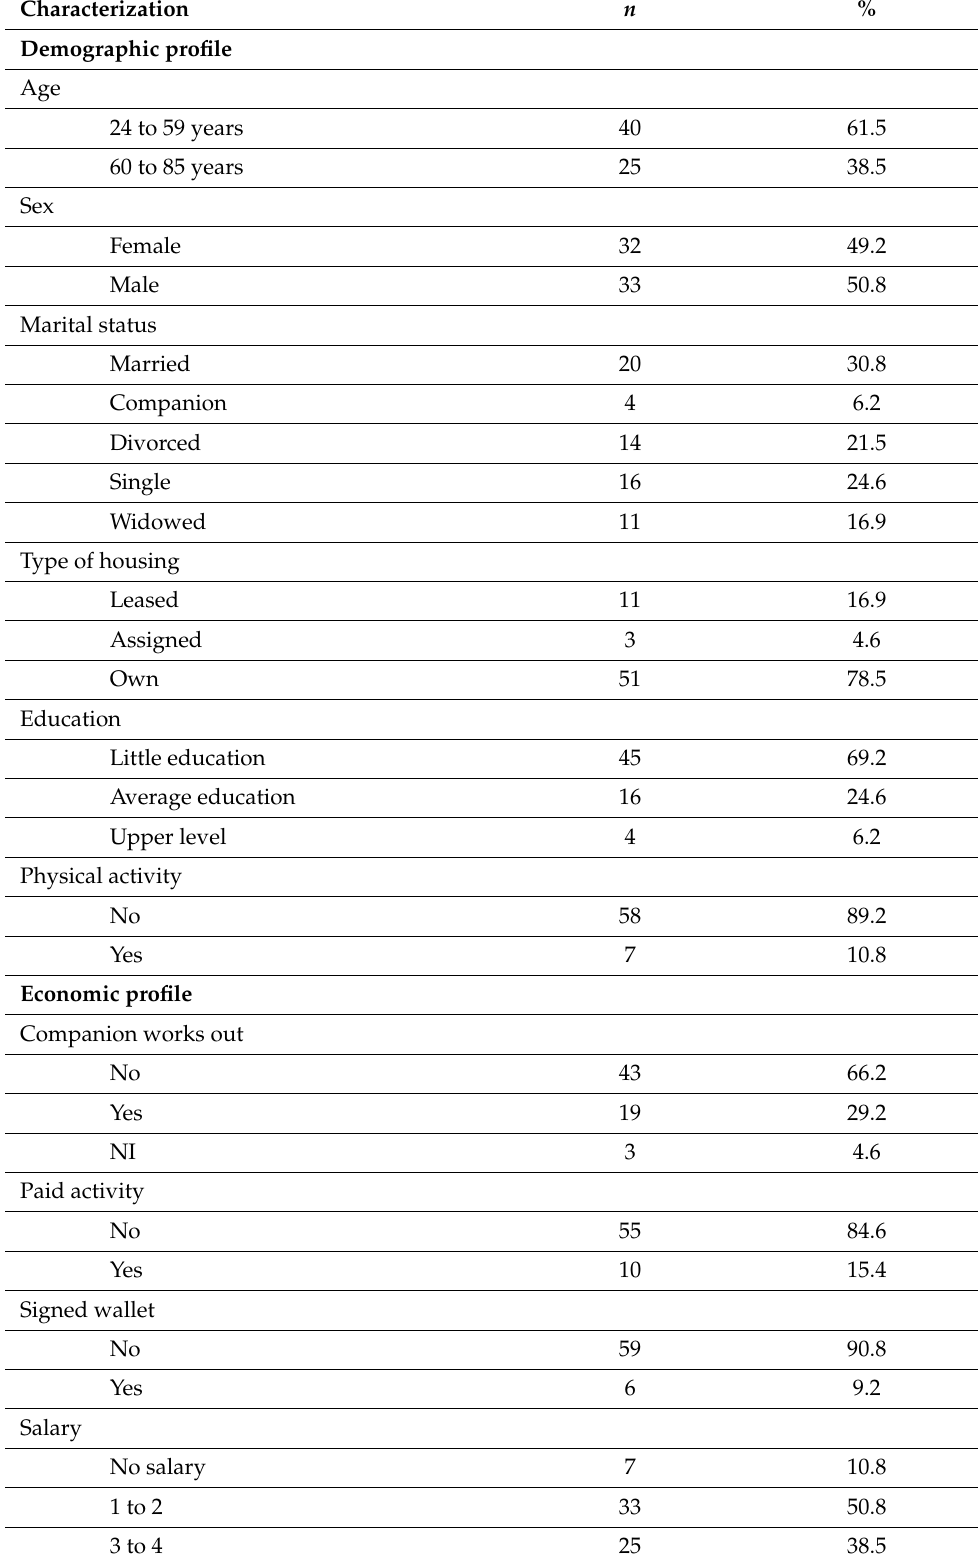
Table 1. Characterization of the demographic and economic profile ( n =